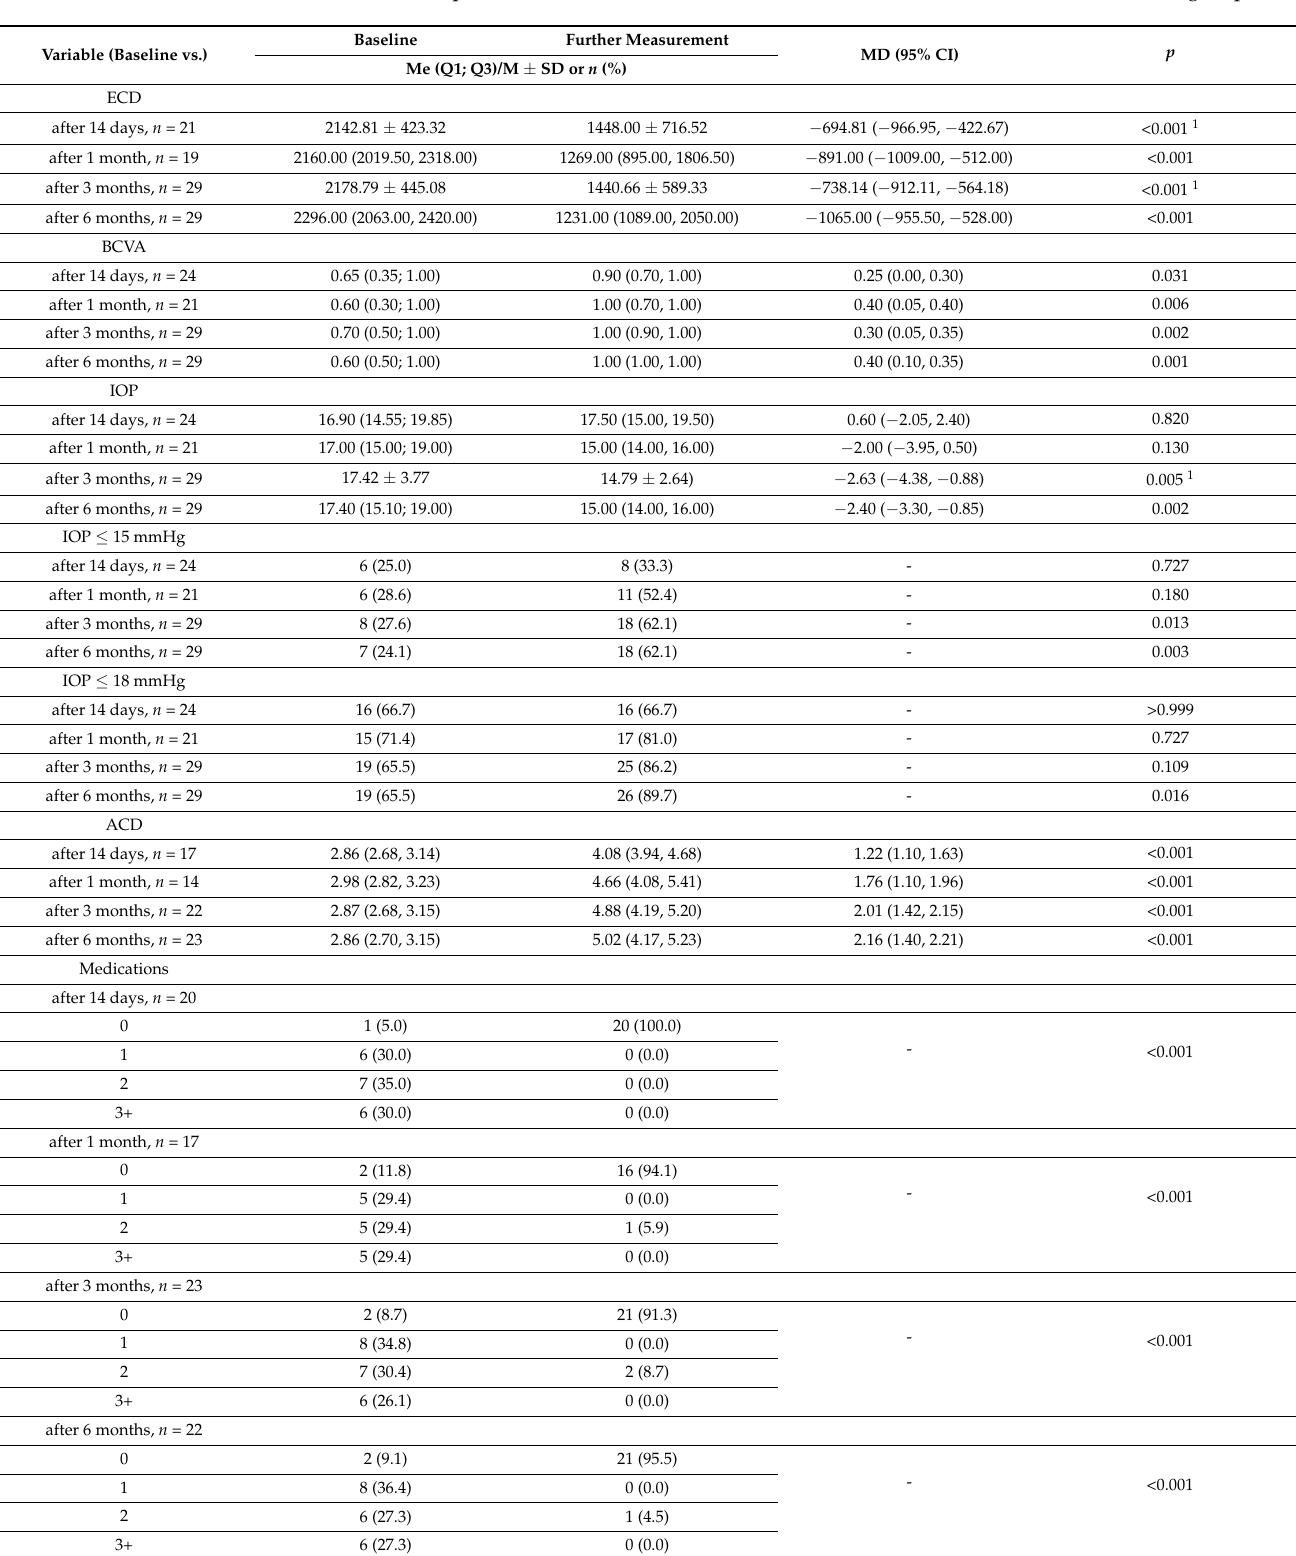
Table 7. Comparison of selected characteristics: baseline vs. further measurements (PiS